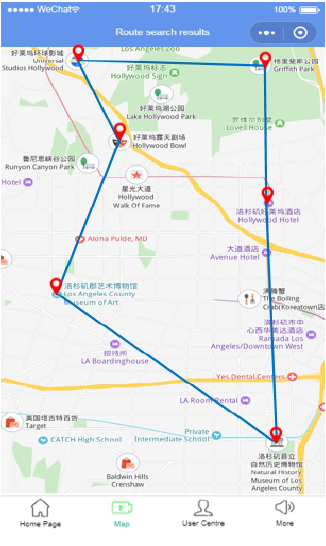
Figure 6. Tourism path